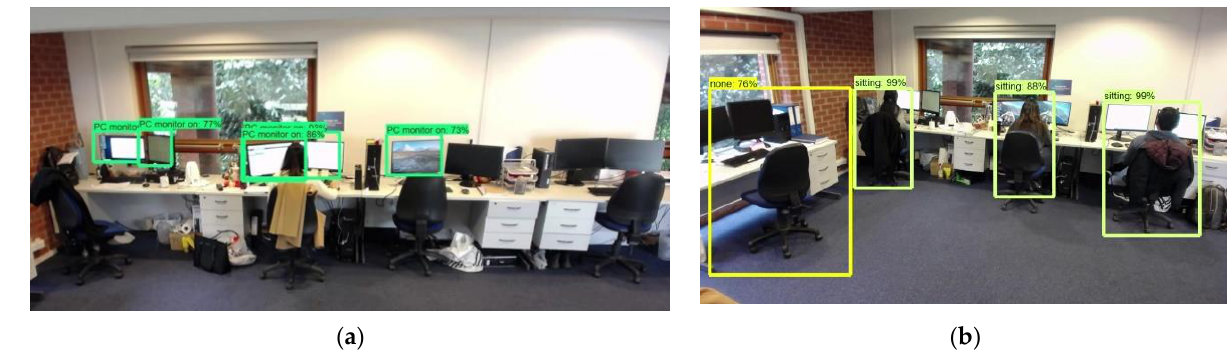
Figure 10. Example of the detection result. ( a ) Equipment detection—PC monitors, ( b ) occupancy activity from the performance of the deep learning detection method within the case study office space.